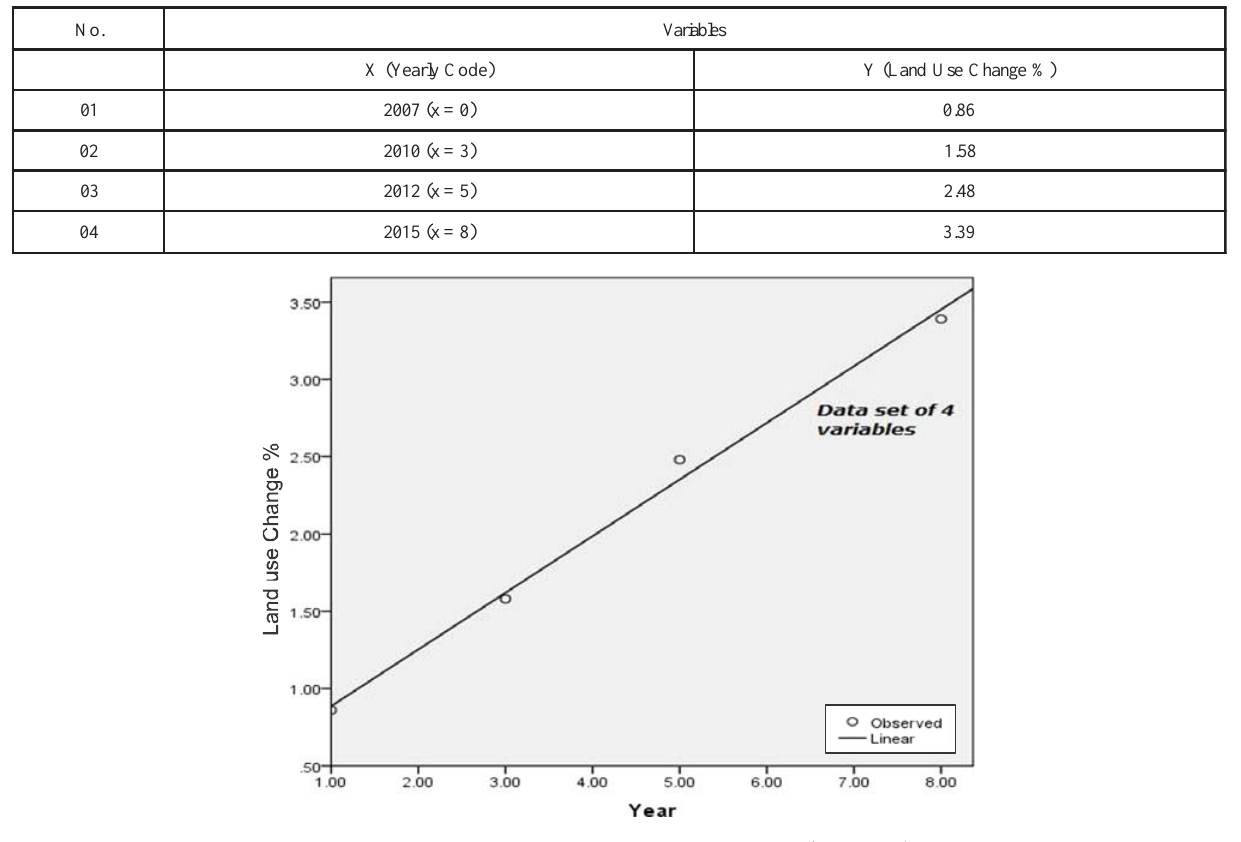
FIG. 3. LAND USE CHANGE PREDICTION MODEL (2007-2015)